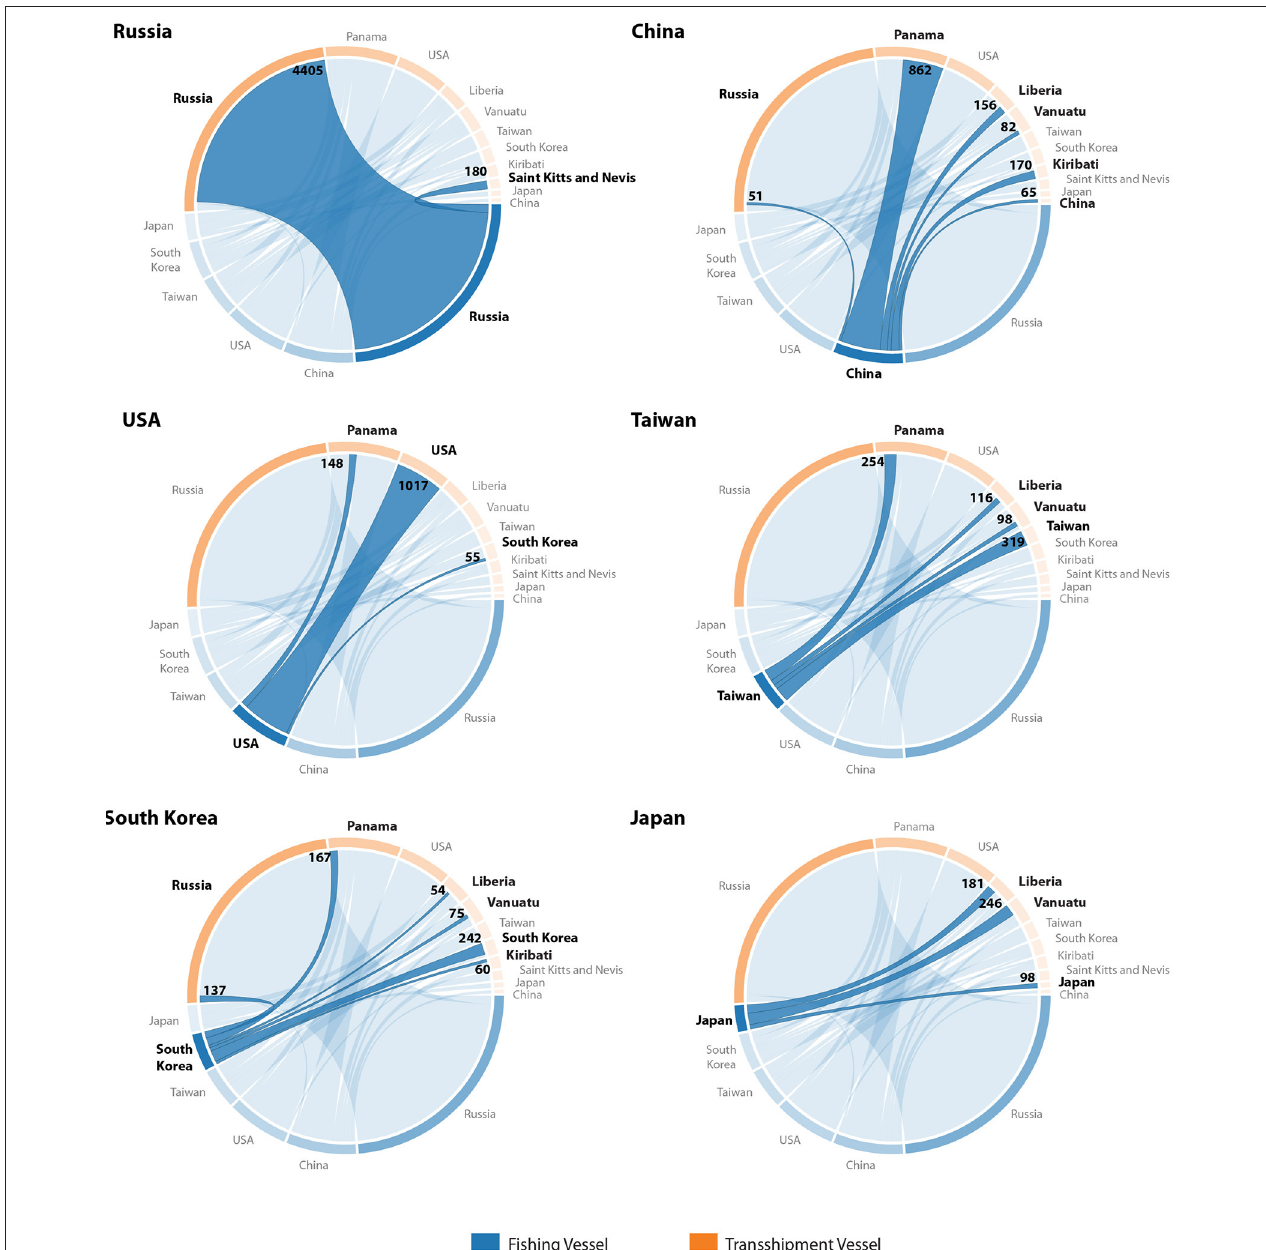
FIGURE 4 | Flag pairings for fishing and transshipment vessels involved in encounters, for the fishing vessel flags with greatest number of encounters. Russian- and US-flagged fishing vessels predominantly associate with common-flagged transshipment vessels, whereas Asian-flagged fishing vessels associate with diversely flagged transshipment vessels. Values identify number of events involving each flag